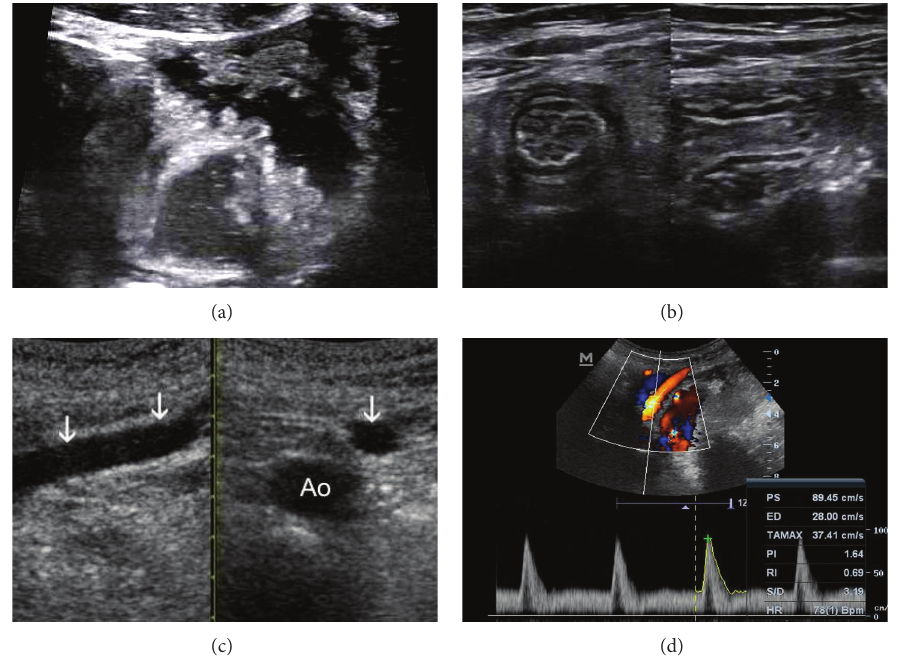
Figure 4: Celiac sprue: (a) Dilated loops of small bowel with thickened wall, and valvulae conniventes hyperperistalsis— standard abdominal probe . (b) Intussusception of jejunum in transverse (left) and longitudinal section in celiac sprue— high resolution probe. (c) Dilated SMA (9mm) in a patient with untreated celiac disease— standard probe . (d) Low resistive index-RI (0.69) in SMA in untreated celiac disease— standard